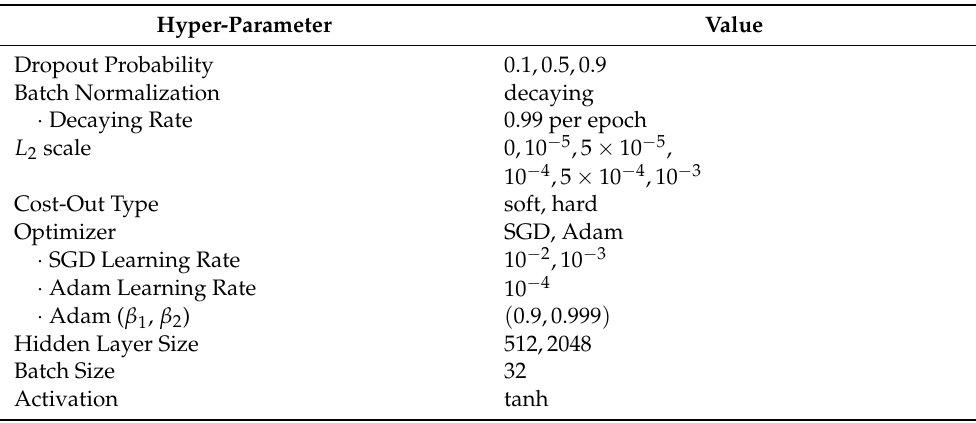
Table 3. Hyper-parameter settings for TDC-same